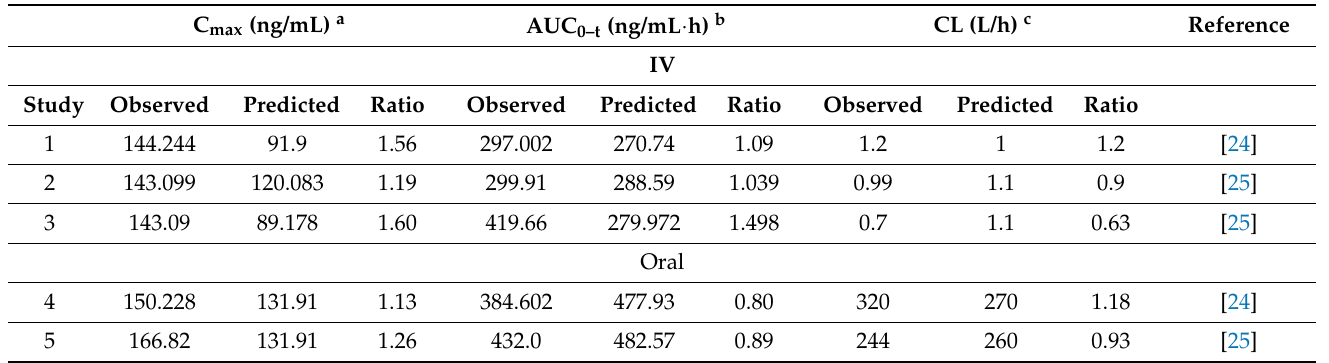
Table 3. Observed and predicted values of various PK parameters and their respective R values in healthy